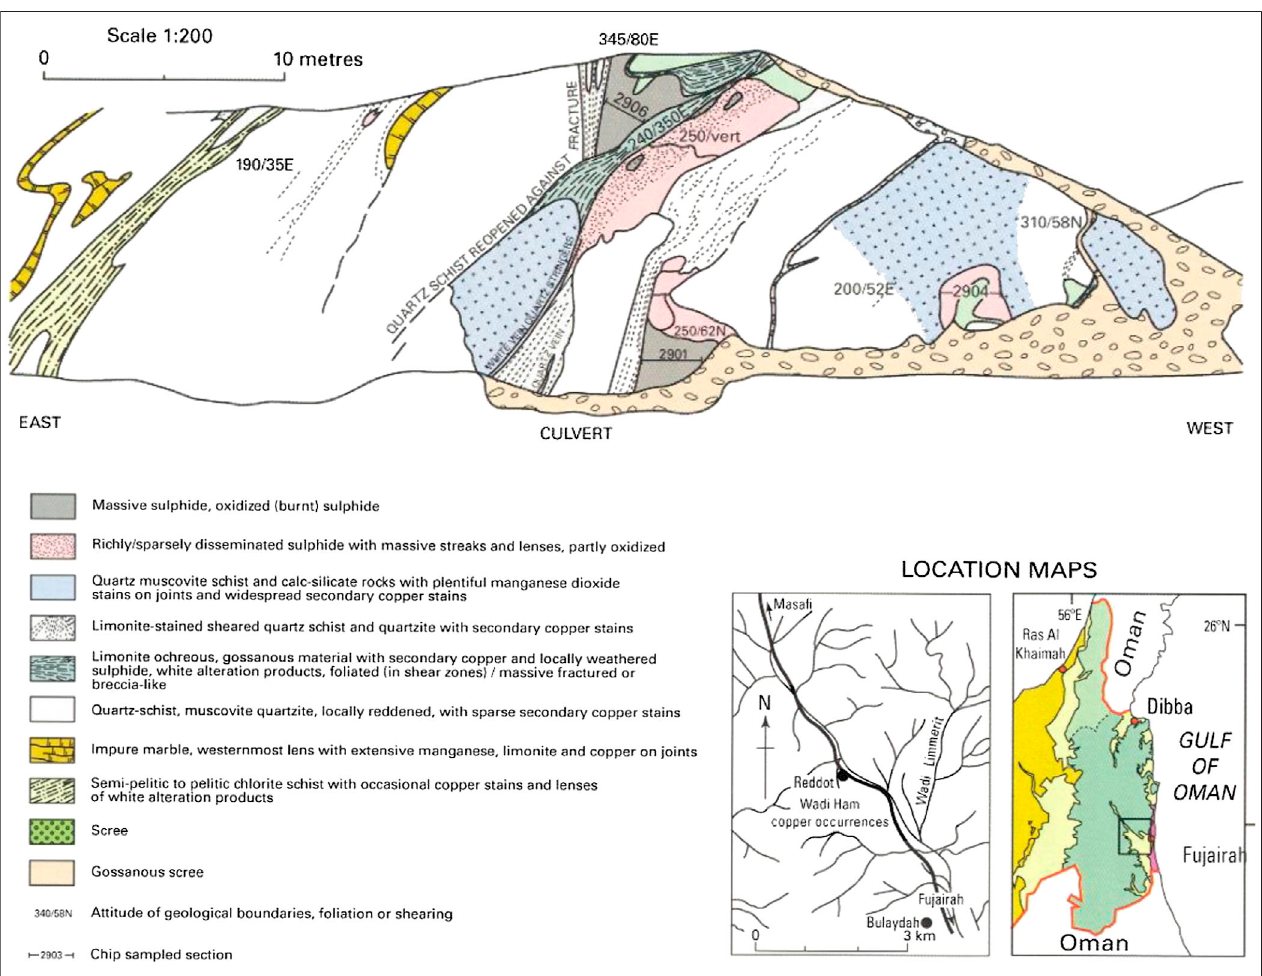
FIGURE3| DetailoftheWadiHamcopperoccurrence,whichislookingtowardthenorthin fi gure.[FromHuntingGeologyandGeophysicsLimited(1983),redrawn by Robins et al. (2006).]